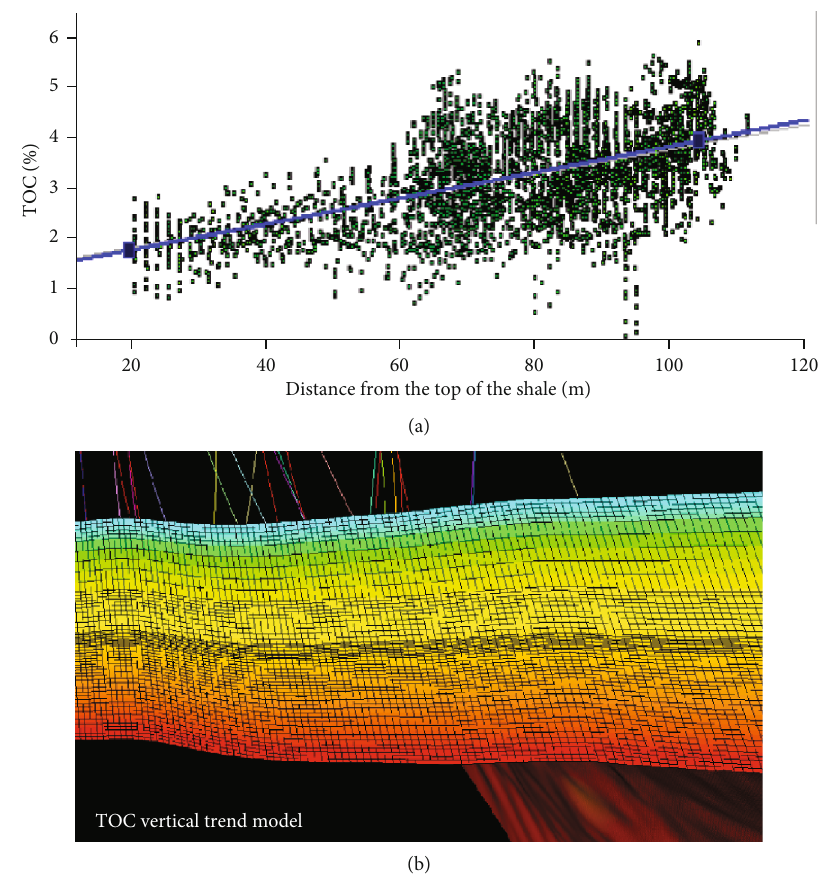
Figure 10: Longitudinal distribution trend of TOC in the Fuling shale gas reservoir. (a) The relationship between the TOC and the distance from the top surface of the shale formation. (b) Longitudinal trend model of the TOC